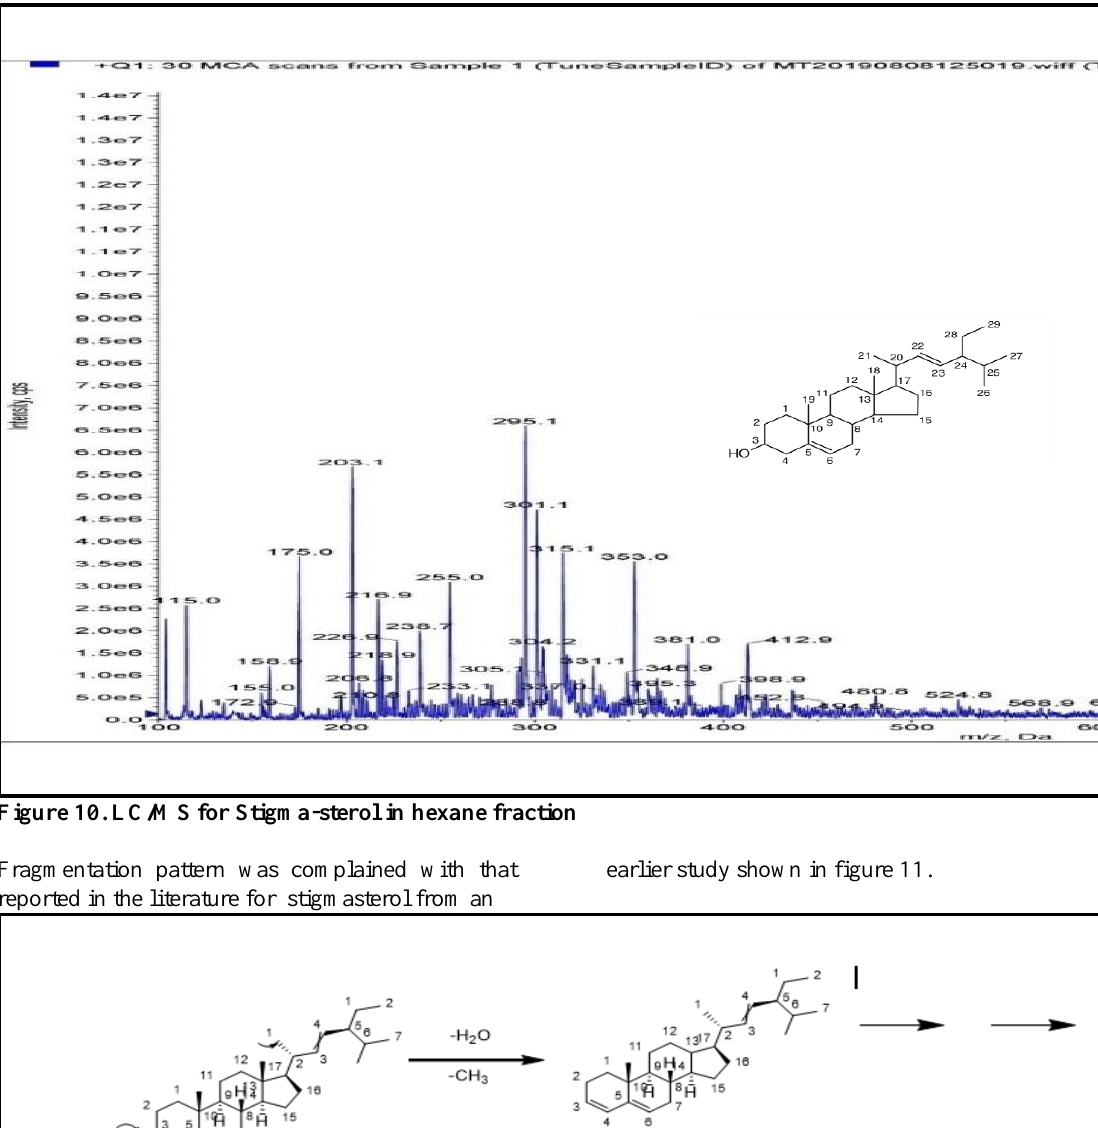
earlier study shown in figure 11.